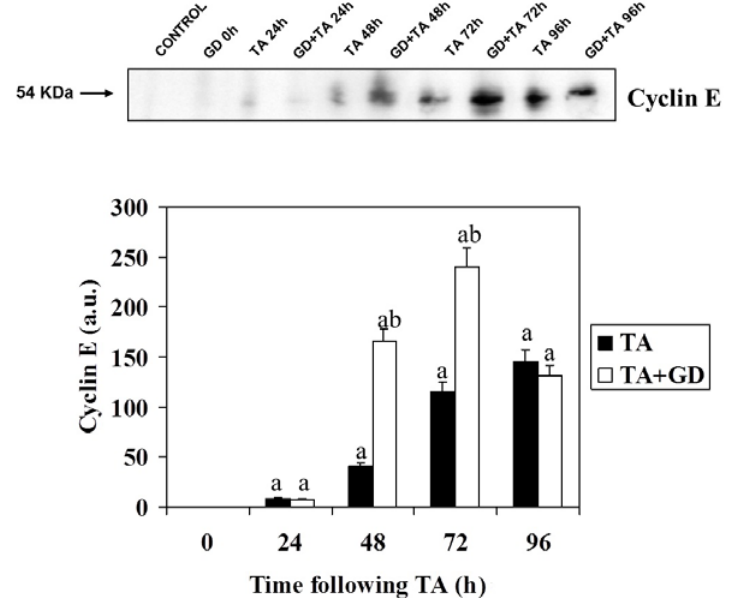
Figure 4. Effect of GD pre-treatment on levels Cyclin E protein assayed by Western blot in liver homogenates of rats intoxicated with one sublethal dose of thioacetamide. Samples were obtained at 0, 24, 48, 72 and 96 h following thioacetamide (TA). The results, expressed in arbitrary units, are the mean ± SD of four determinations in duplicate from four rats. Differences against the respective control are expressed as (a) and differences due to GD are expressed as (b) p <